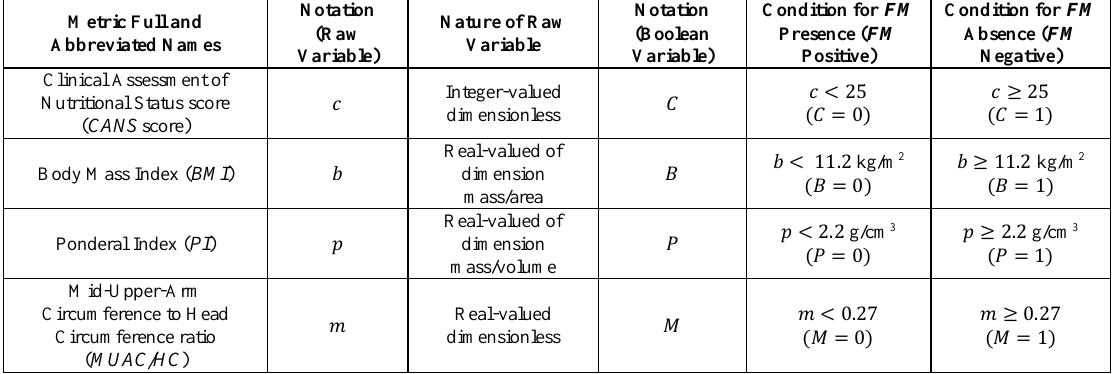
Table 1. The four metrics used for FM assessment in Rushdi (2017) and in the current